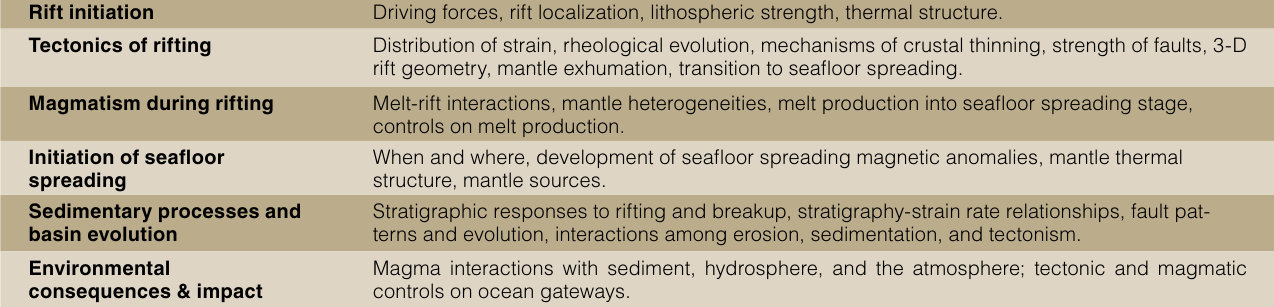
Table 1. Key aspects of continental breakup. Rift initiation Driving forces, rift localization, lithospheric strength, thermal structure. Tectonics of